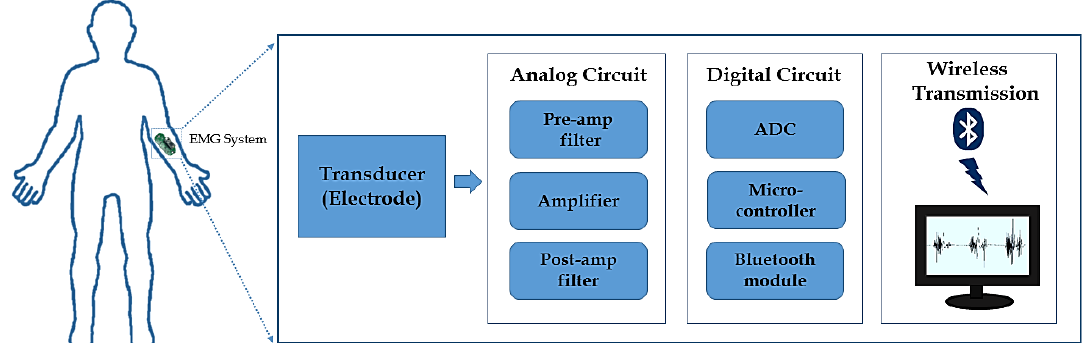
Figure 3. Schematic illustration of the EMG measurement system.